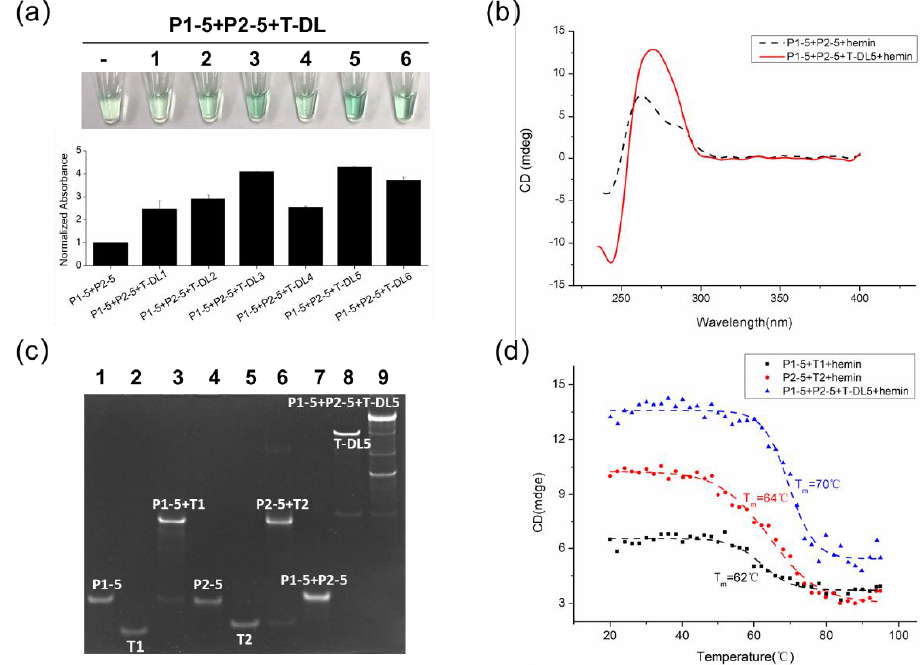
Figure 4. ( a ) Colorimetric photograph (upper) and normalized absorbance (bottom) of 1 µ M of the molecular beacons P1-5 and P2-5 in the absence or presence of 0.05 µ M of each of the targets with two adjacent hybridization sites separated by 6 to 1 nt. ( b ) CD spectra of 1 µ M of the molecular beacons P1-5 and P2-5 in the absence or presence of 1 µ M T-DL5 followed by the addition of 2 µ M hemin in the colorimetric buffer. ( c ) The electrophoresis band of the molecular beacons (line 1: P1-5; line 2: P2-5), the separated targets (line 2: T1; line 5: T2), the optimized target consisting of two adjacent hybridization sites separated by 5 nt (line 8: T-DL5) and the mixture of the molecular beacons with their corresponding targets (line 3: P1-5 + T1; line 6: P2-5 + T2; line 9: P1-5 + P2-5 + T-DL5). All the samples were prepared in colorimetric buffer and the concentration of each of the ODN was 1 µ M. ( d ) The CD melting curve of 1 µ M of P1-5 and P2-5 with 1 µ M of their corresponding separated targets or the optimized target T-DL5 followed by the addition of 2 µ M hemin in the colorimetric